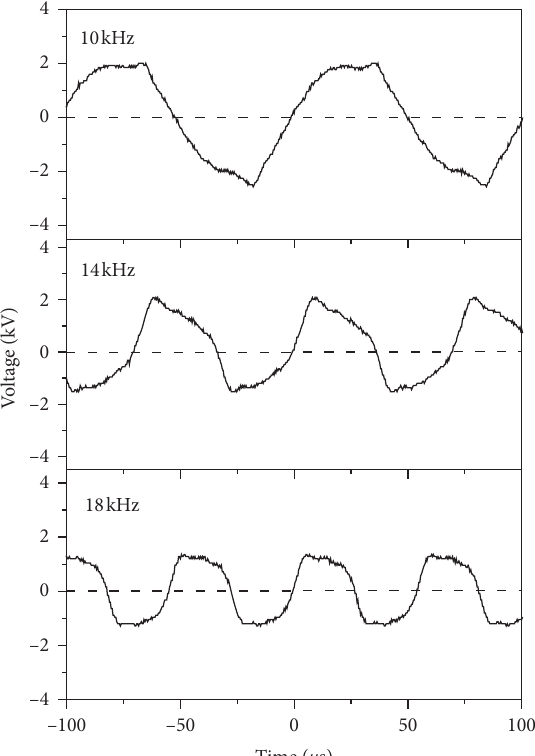
Figure 3: Typical voltage waveforms of the He-plasma jet with different